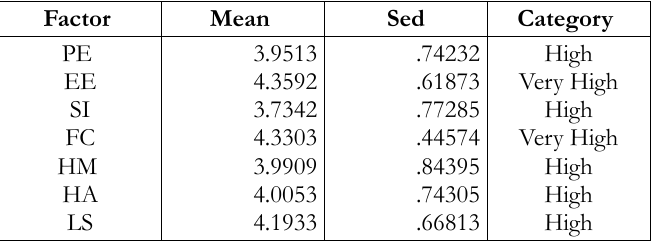
Table 4. the means and the standard